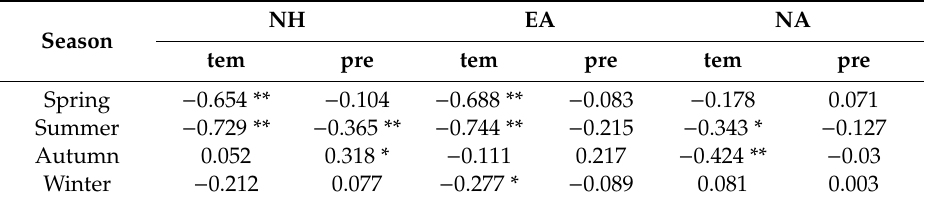
Table 1. Pearson’s correlation coe ffi cients between SCE and temperature (tem), precipitation (pre) in di ff erent seasons over the NH, EA, and NA during the period of 1967–2018. ‘*’ denotes significance at the 0.05 level and ‘**’ denotes significance at the 0.01